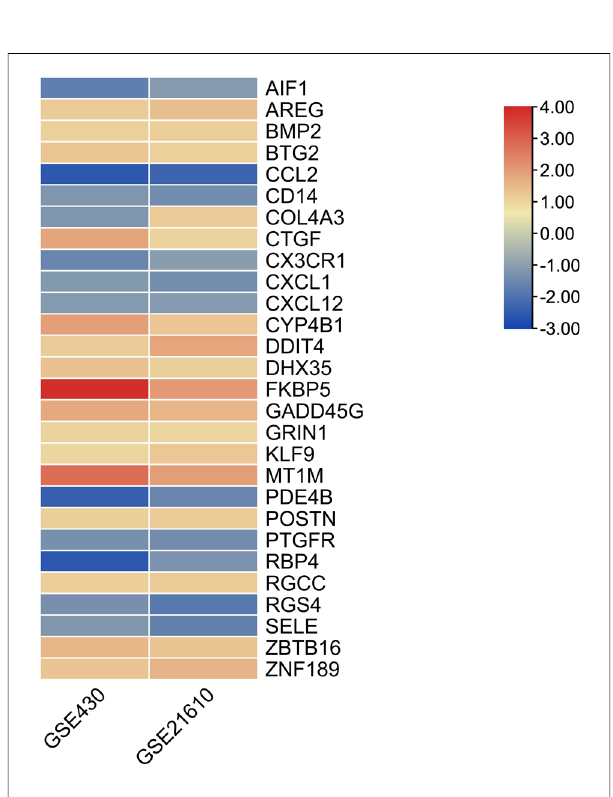
FIGURE 3 Heatmap of the differentially expressed genes in the